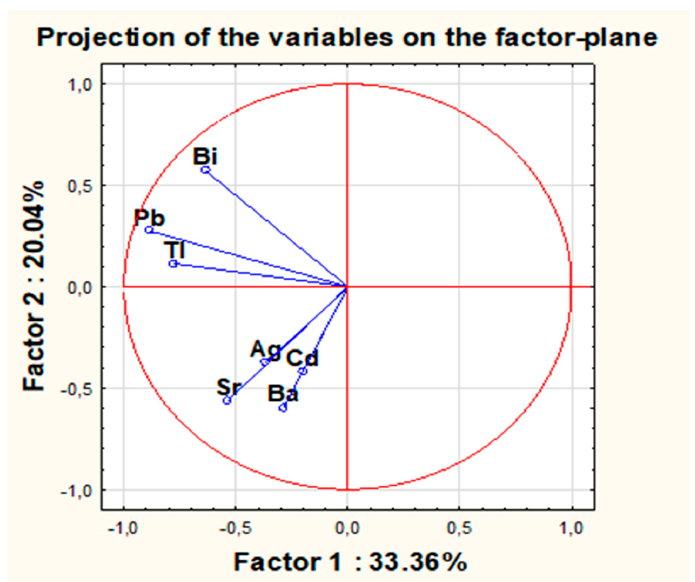
Figure 7. Projection of variables on the factor plane for the first two components.